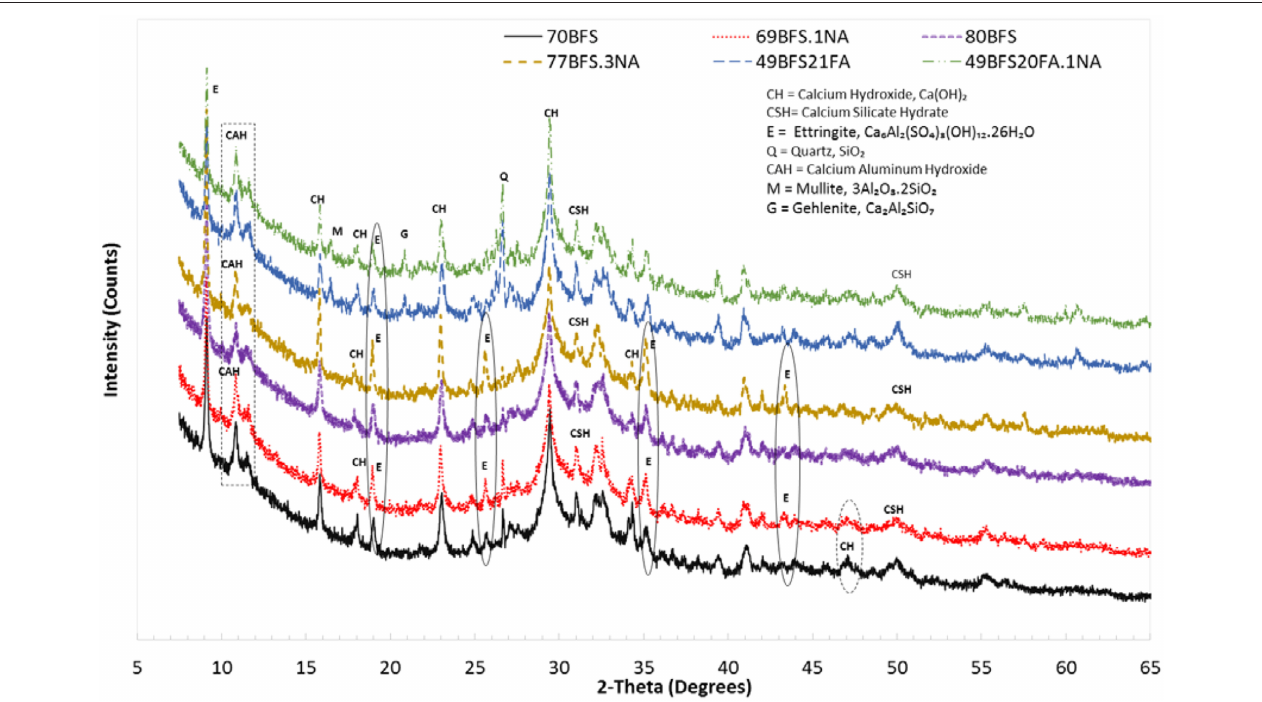
FIGURE 7 | XRD analysis of HVS and HVS-FA pastes with and without nano alumina.